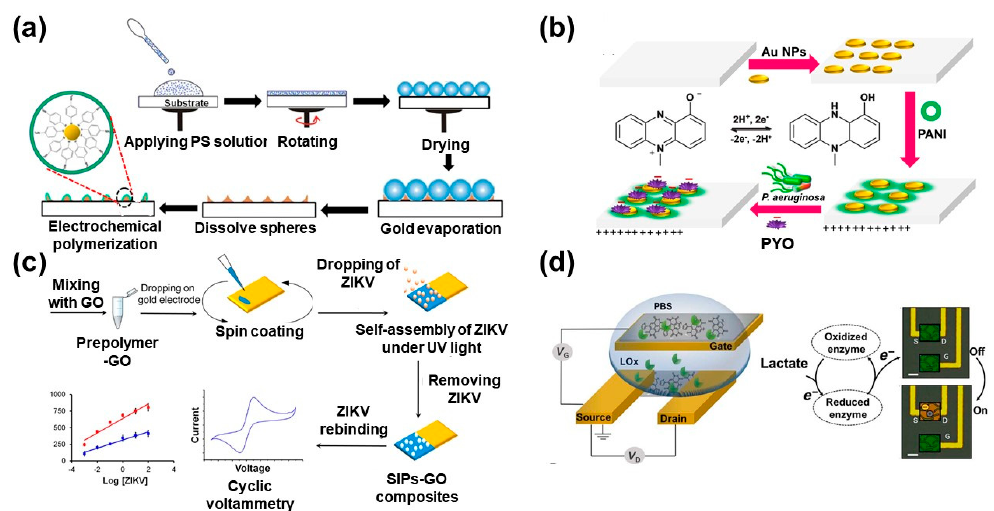
Figure 3. ( a ) Preparation of PATP nanostructures patterns gold modified Indium Tin Oxide. Reproduced with permission [39]. Copyright 2014 Elsevier. ( b ) The schematic diagram for the fabrication of polyaniline (PANI)/Au NPs/ITO electrode and the interaction between PANI and pyocyanin (Pyocyanin (PYO) [43]. ( c ) Scheme depicting surface imprinted polymers (SIPs)-graphene oxide composites preparation on a gold surface for making the ZIKV biosensor. Reproduced with permission [44]. Copyright 2019 ACS publication. ( d ) Schematic of the organic electrochemical transistor (OECT) (gate dimensions, 500 mm 2 ; channel dimensions, 10 mm (length) × 100 mm (width) × ~100 nm (thickness)) [45].